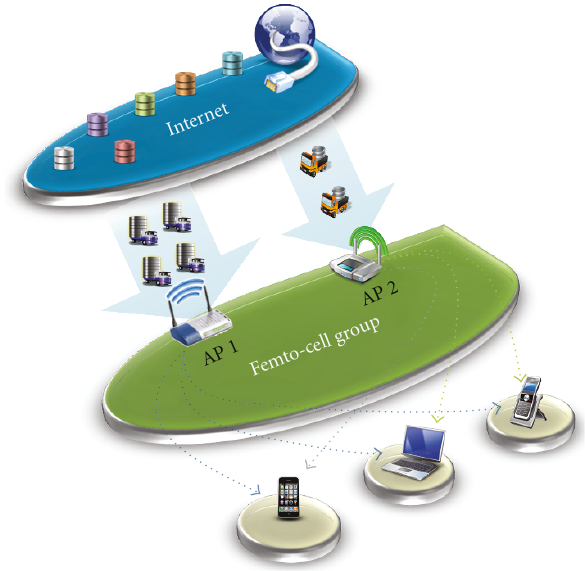
Figure 1: Illustration of femto-cell group with distributed network information flow.